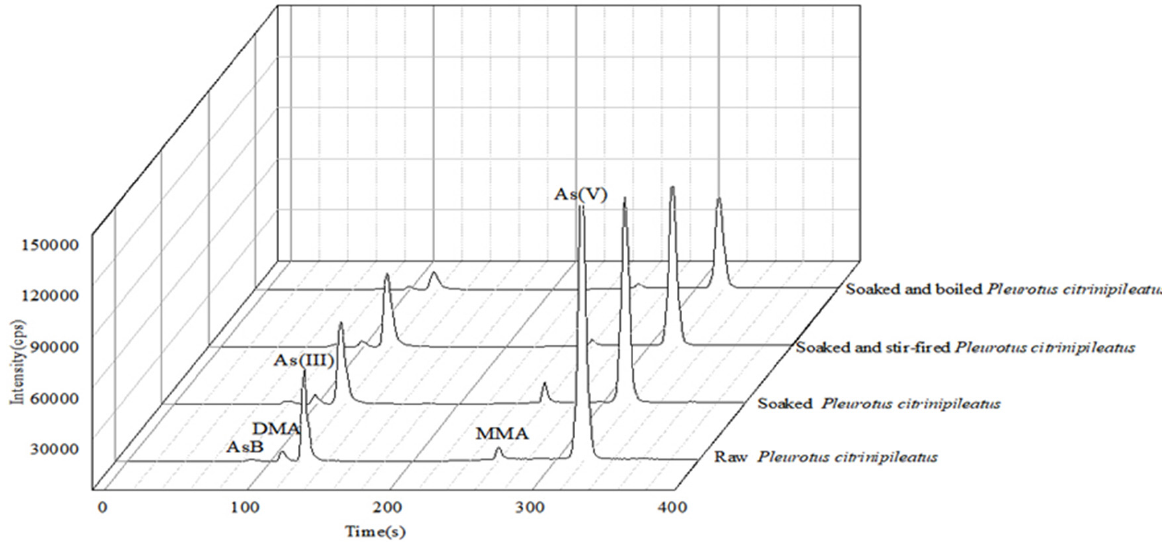
Figure 2. As speciation changes in Pleurotus citrinipileatus after different cooking methods.